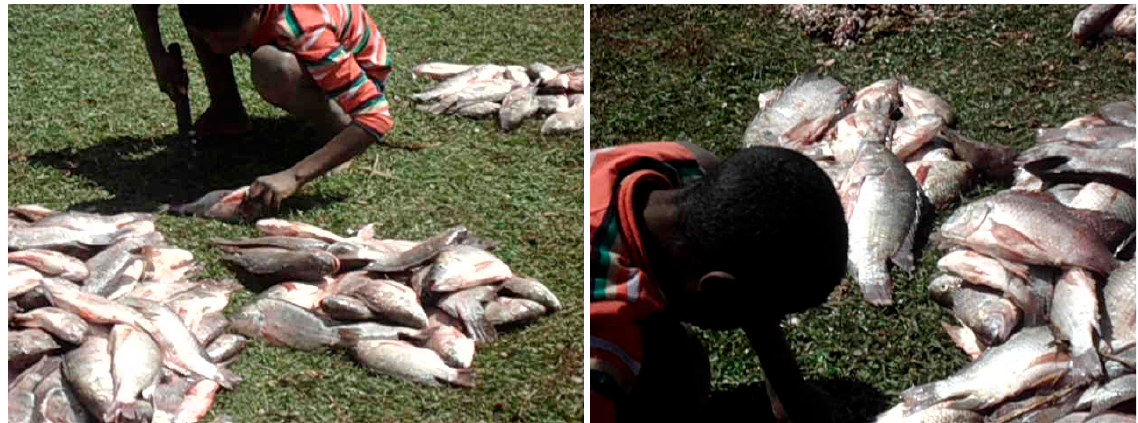
Figure 9. Fish harvest locally in Lake Tana at eastern shore.